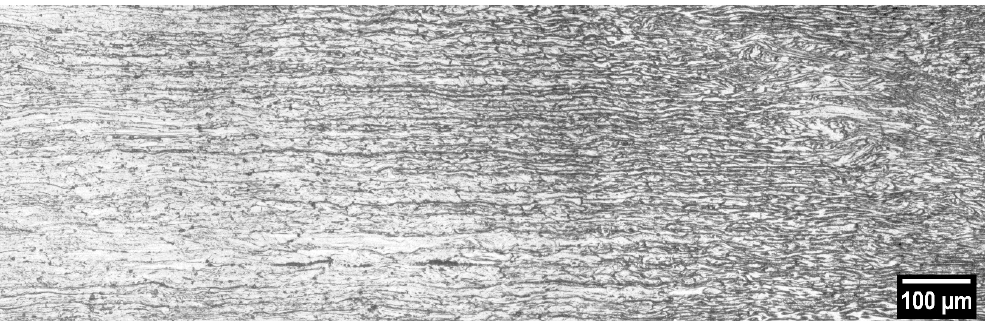
Figure 9. Cracks at the surface after 50% cold rolling.